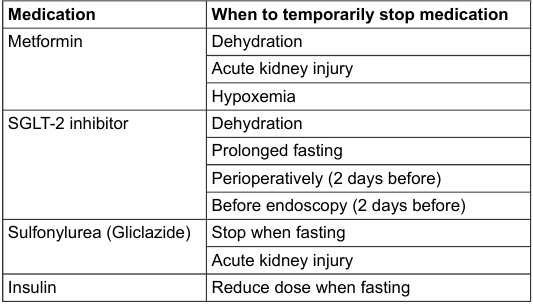
Table 3: When to discontinue or change antidiabetic